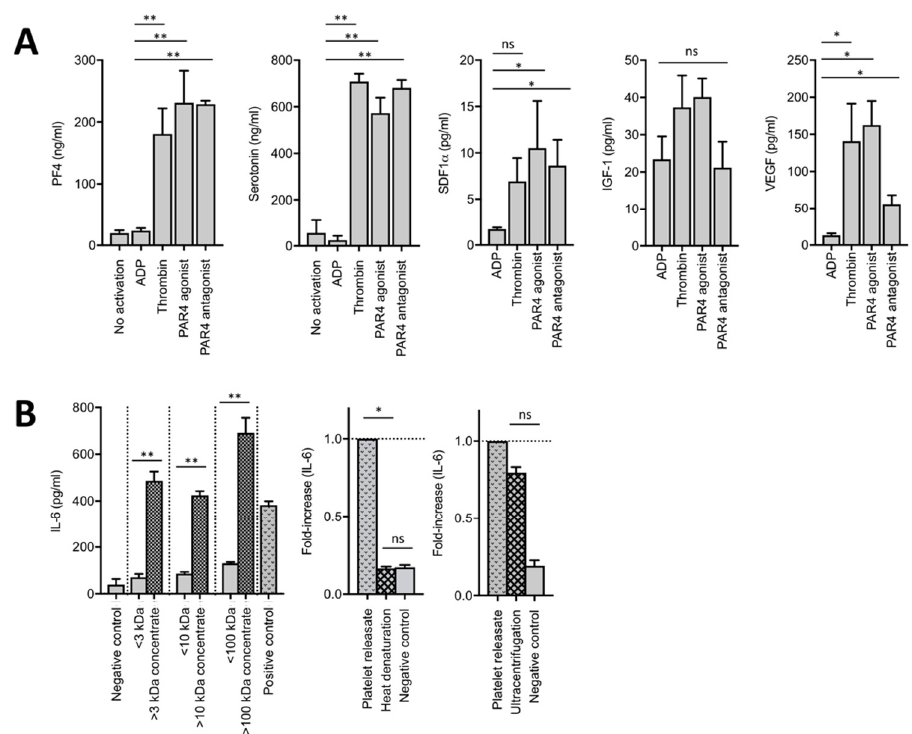
Figure 4. The e ff ect of platelets is mediated through a > 100 kDa protein contained in platelets. ( A ) Concentrations of PF4, serotonin, SDF-1 α , IGF-1, and VEGF in releasates of platelets activated either by adenosine diphosphate—ADP, thrombin, a PAR4 agonist, or a PAR4 antagonist associated with thrombin. N = 2–5 (depending on experimental group), * p < 0.05, ** p < 0.001. ( B ) Left panel: IL-6 secretion at 24 h of culture of LSECs with fractions of the platelet releasates obtained by exclusion after concentration using Amicon centrifugation devices. Middle panel: Ratio of IL-6 secretion from LSECs after heat denaturation of the releasate of activated platelets. N = 3. Right panel: Ratio of IL-6 secretion from LSECs after ultracentrifugation of the releasate of activated platelets. N = 3.